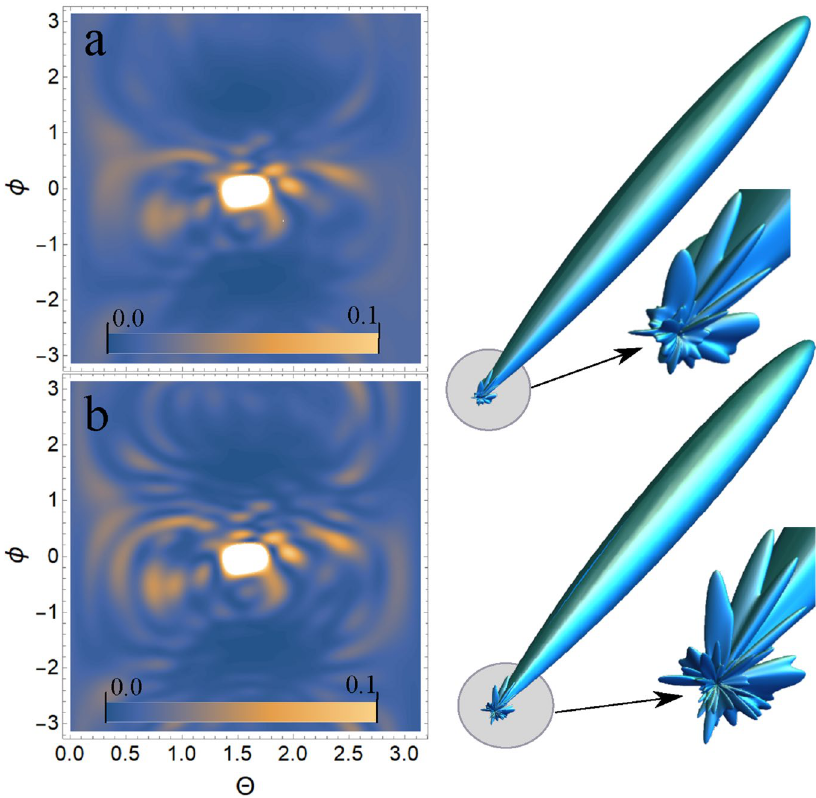
Figure 9. Scattering spectra of USP on cytosine are presented. The rest is the same as on Fig.